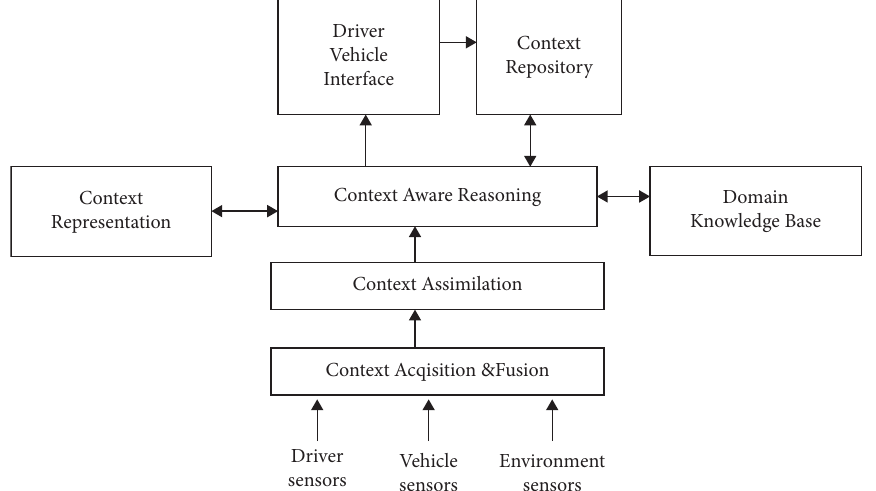
Figure 7: Architecture of intelligent ADAS.